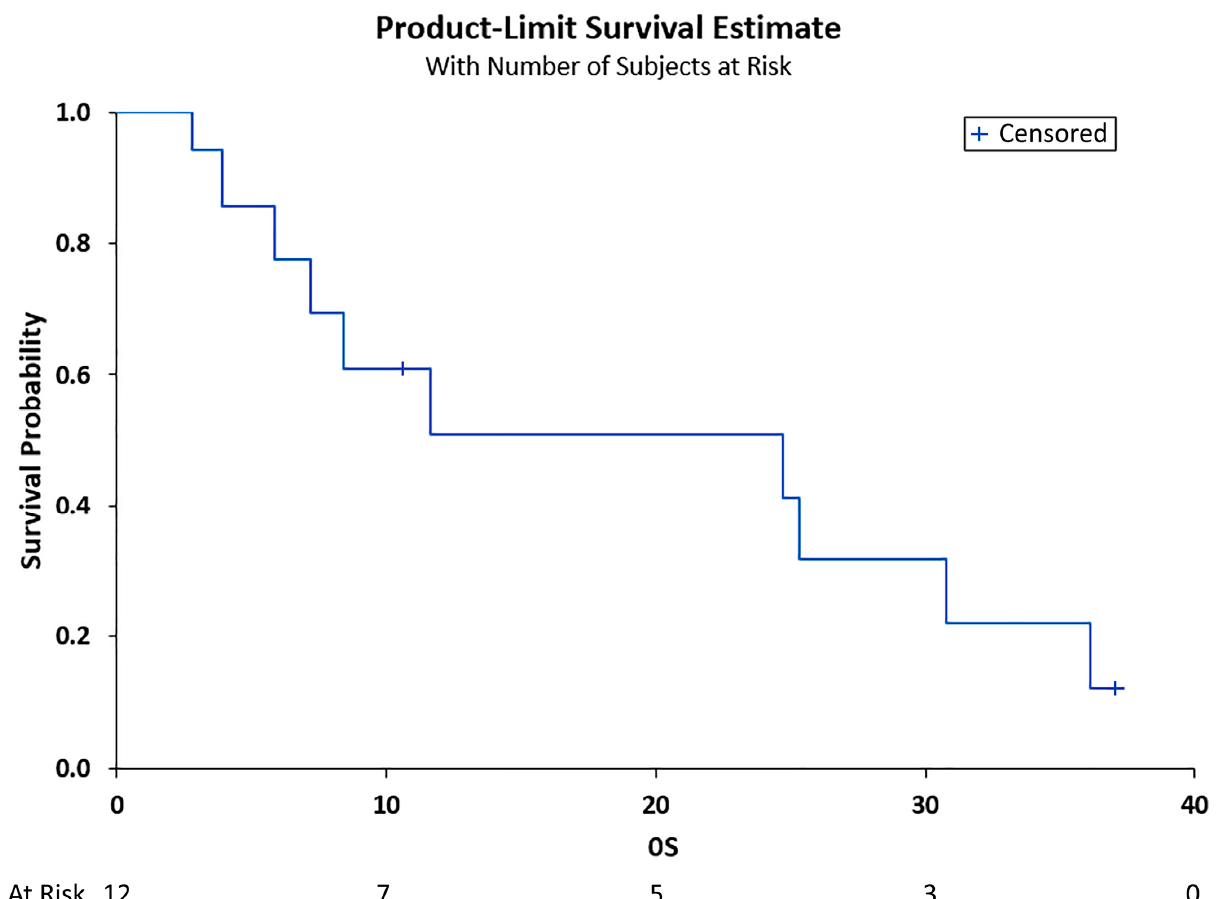
Figure 2. Overall survival (OS) in months. Shown is the OS after treatment for the total cohort of 12 patients vs. the overall survivability probability. Median OS was 11.7 months (95% CI (3.87, 30.85)).